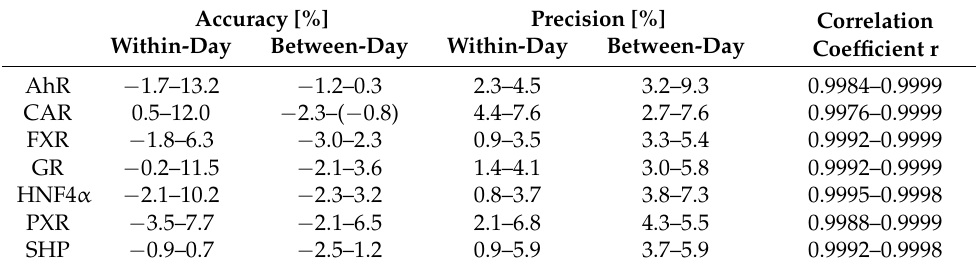
Table 2. Validation data of within-day and between-day accuracy and precision, as well as correlation coefficients, of the respective calibration curves for the simultaneous quantification of the nuclear receptor peptides. Validation range was 0.1–50 nmol/L and data were calculated from, in each case, six quality control samples sets (0.5, 5 and 50 nmol/L) measured on one day (within-day data) or on different days (between-day data). Accuracy is given as relative error of nominal concentrations and precision as coefficients of variation of mean concentrations. AhR, aryl hydrocarbon receptor; CAR, constitutive androstane receptor; FXR, farnesoid X receptor; GR, glucocorticoid receptor; HNF4 α , hepatocyte nuclear factor 4 α ; PXR, pregnane X receptor; SHP, small heterodimer partner. Accuracy [%] Precision [%] Correlation Coefficient rWithin-Day Between-Day Within-Day Between-Day AhR